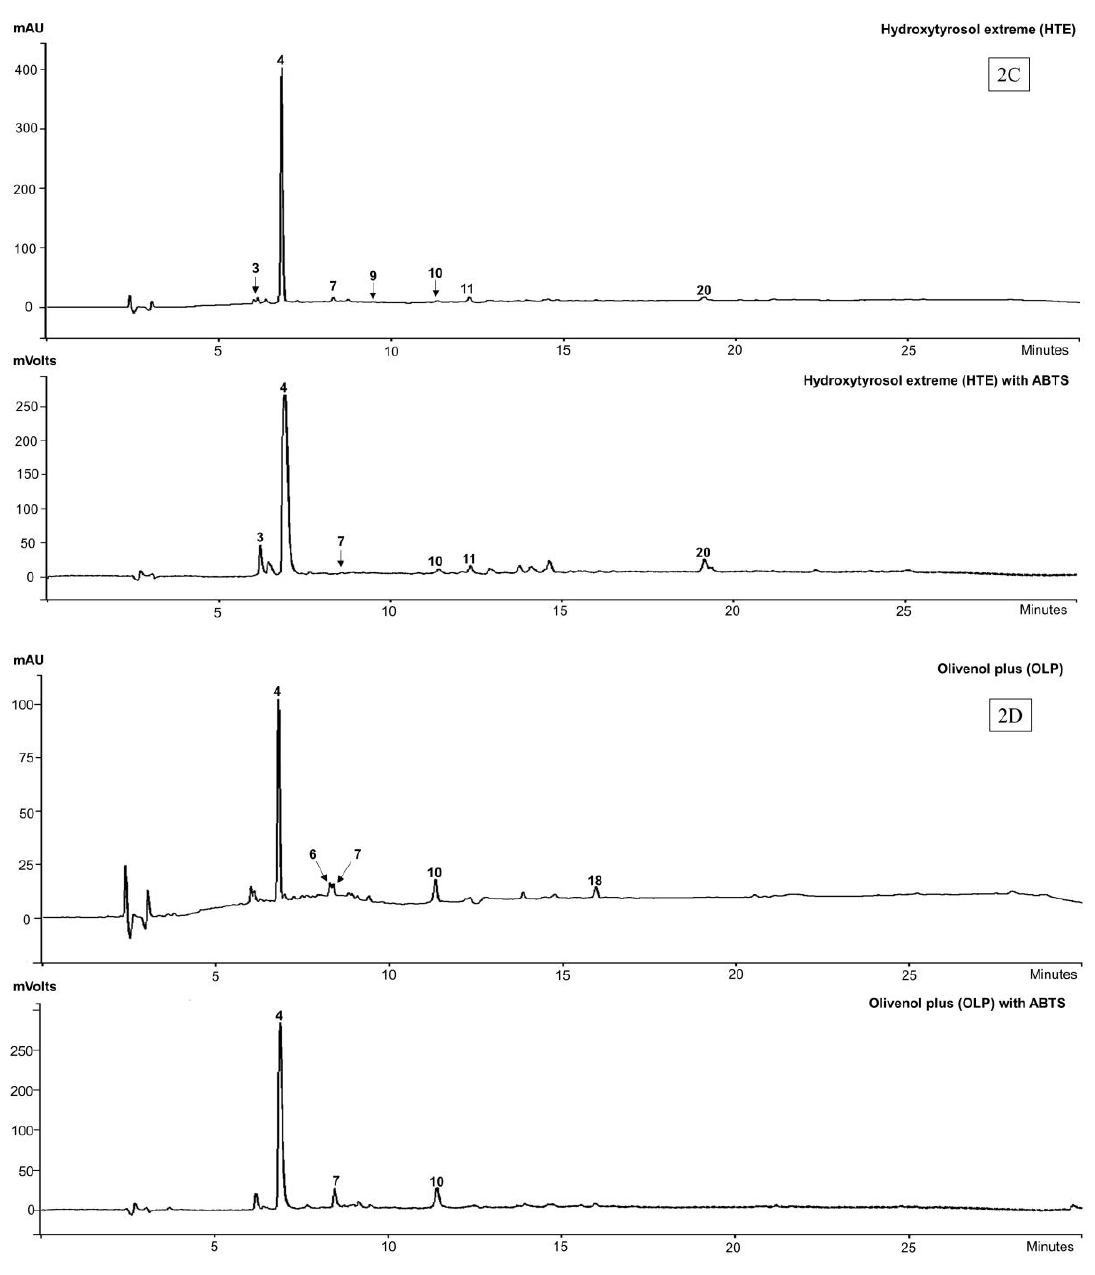
Figure 2. HPLC-DAD-ABTS chromatograms of four commercial extracts of olive at 280 nm and ABTS scavenging at 414 nm. ( 2A ) olive leaf extracts (OLE); ( 2B ) olive fruit extracts (OFE); ( 2C ) Hydroxytyrosol Extreme TM (HTE) and ( 2D ) Olivenol Plus TM (OLP).